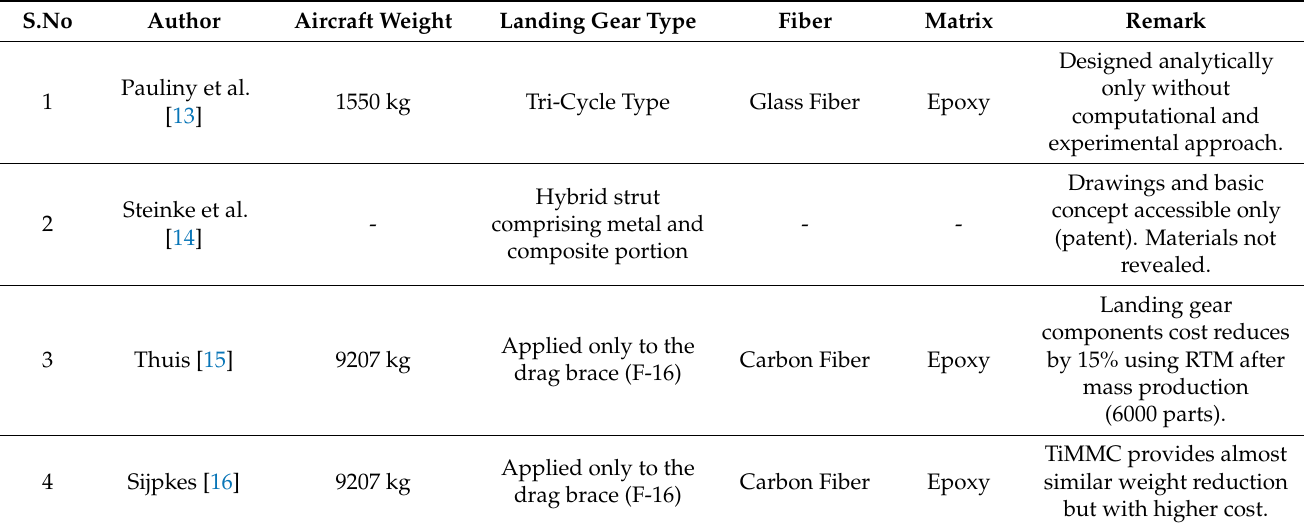
Table 1. Details of fiber-reinforced composite landing gears and associated components found in the